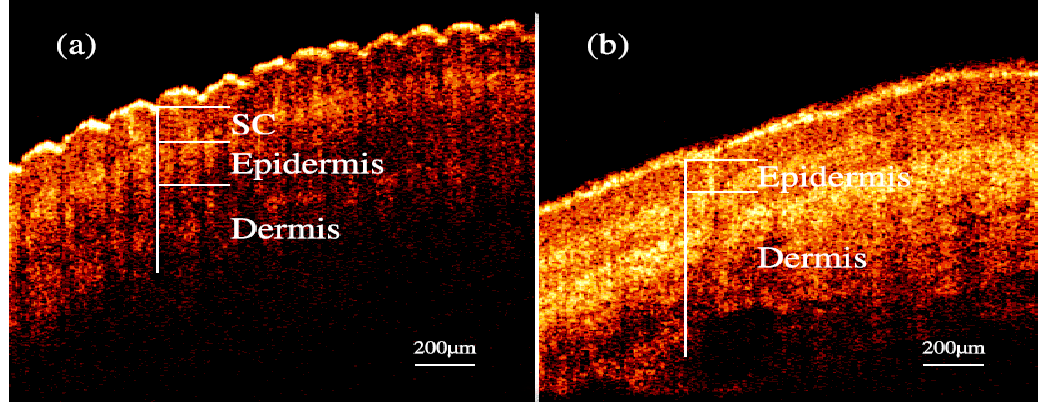
Figure 2. OCT images of skin. ( a ) fingertip. ( b ) nailfold.